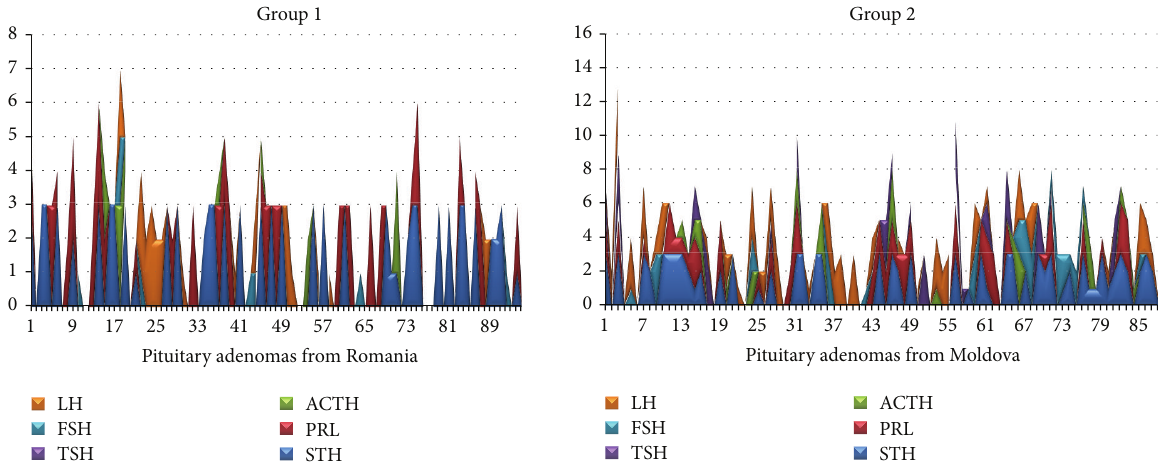
Figure 2: Mapping of pituitary adenomas hormone profiles was comparatively highlighted by overlapping charts for all six hormone types. The differential distribution and density of cases positive for different kinds of hormones between the two groups were shown.